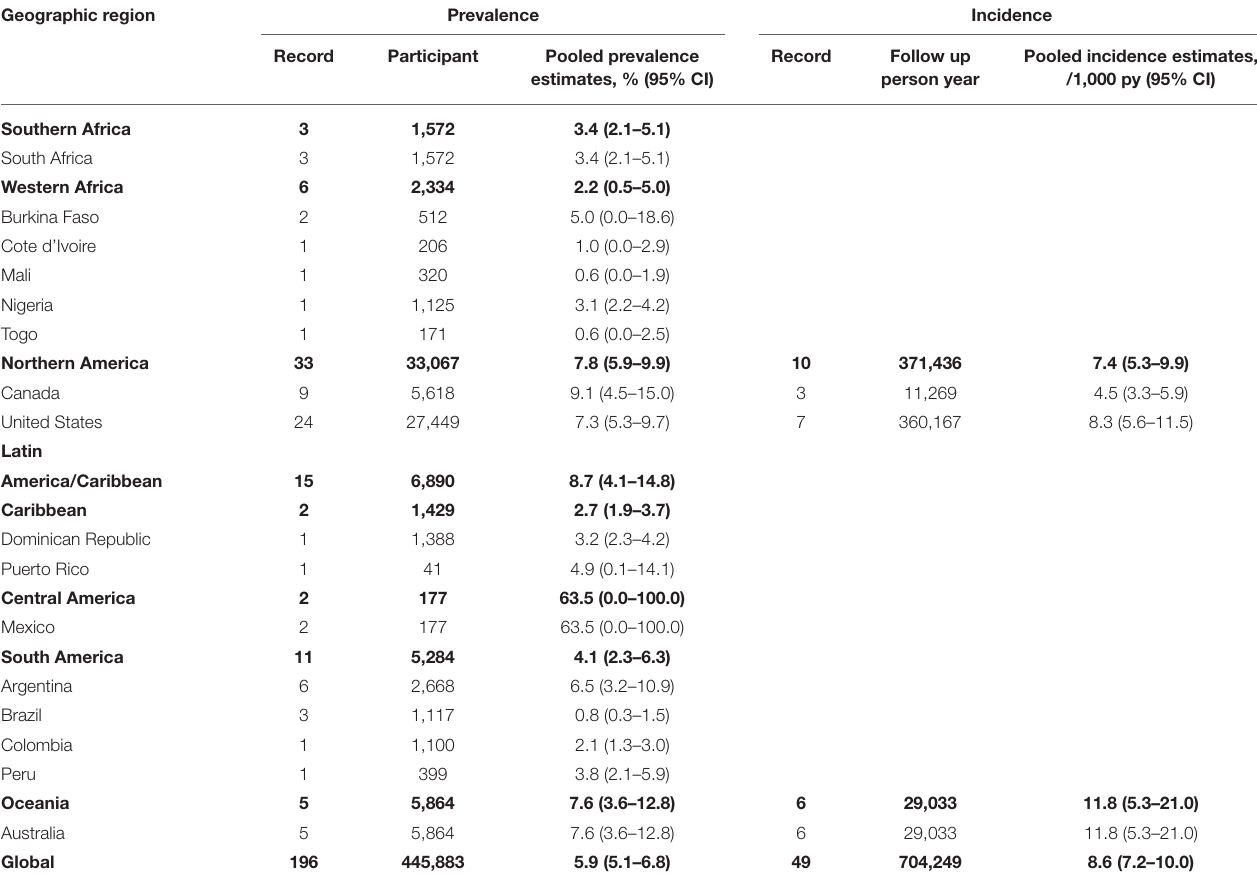
* There is a multi-center incidence study conduct in the whole Europe. HCV, hepatitis C virus; CI, confidence interval. Bold values represent results at the global or regional level, and non-bold values represent results at national level.